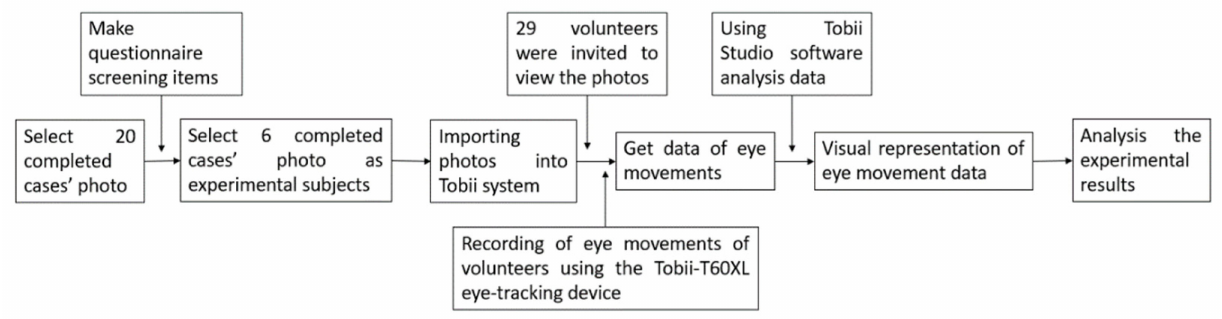
Figure 2. Flow chart of experimental